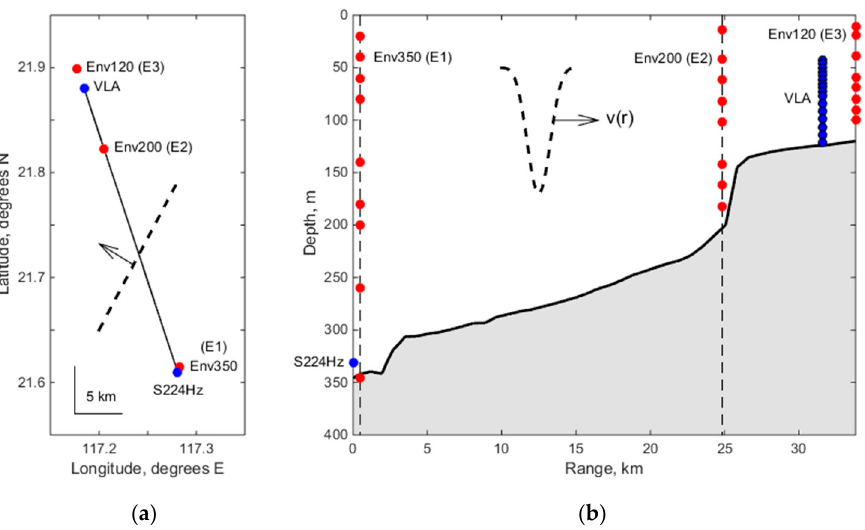
Figure 3. Schematic of the experiment: ( a ) top view, ( b ) view perpendicular to the track. S224 is the source, VLA is the receiving array, Env denotes three thermistor strings. The soliton is shown with a bold dotted line.